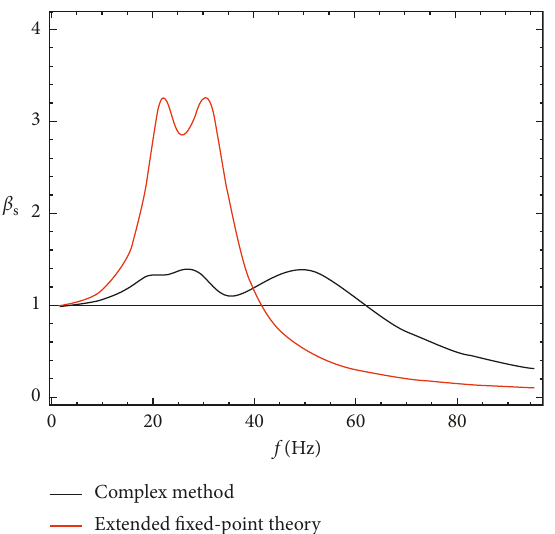
Figure 9: Change of the dynamic displacement transfer coefficient with